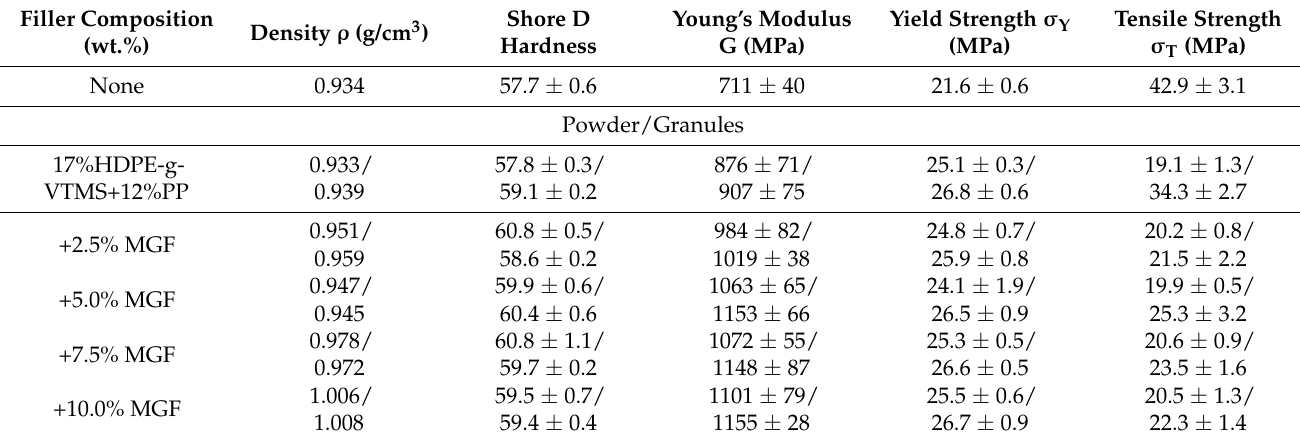
Table 3. The mechanical properties of neat UHMWPE and the ‘UHMWPE+17% HDPE-g-VTMS+12% PP’-based composites loaded with MGF (200 µ m in